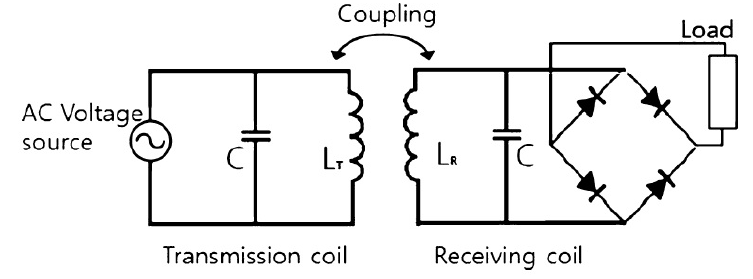
Figure 2. Typical block diagram for wireless power transfer